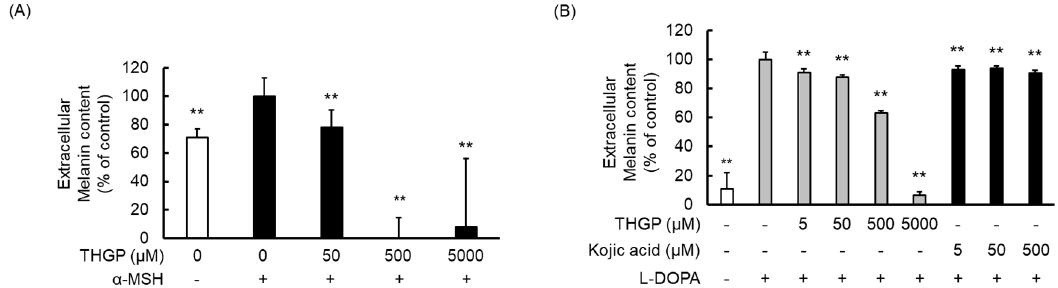
Figure 6. Inhibitory effect of THGP on melanin production after stimulation with α -MSH or L-DOPA. ( A ) The extracellular melanin levels in B16 4A5 melanoma cells under α -MSH activation were measured after treatment with THGP or kojic acid for 72 h. ( B ) The amount of extracellular melanin in B16 4A5 melanoma cells stimulated with L-DOPA was evaluated after treatment with THGP or kojic acid for 48 h. The results were statistically analyzed by Dunnett’s method, and 0 µ M THGP with α -MSH or L-DOPA stimulation served as the control. “ − ” means untreated group and “ + ” means treated group about THGP, α -MSH or L-DOPA. The data are reported as the means ± SDs from six independent